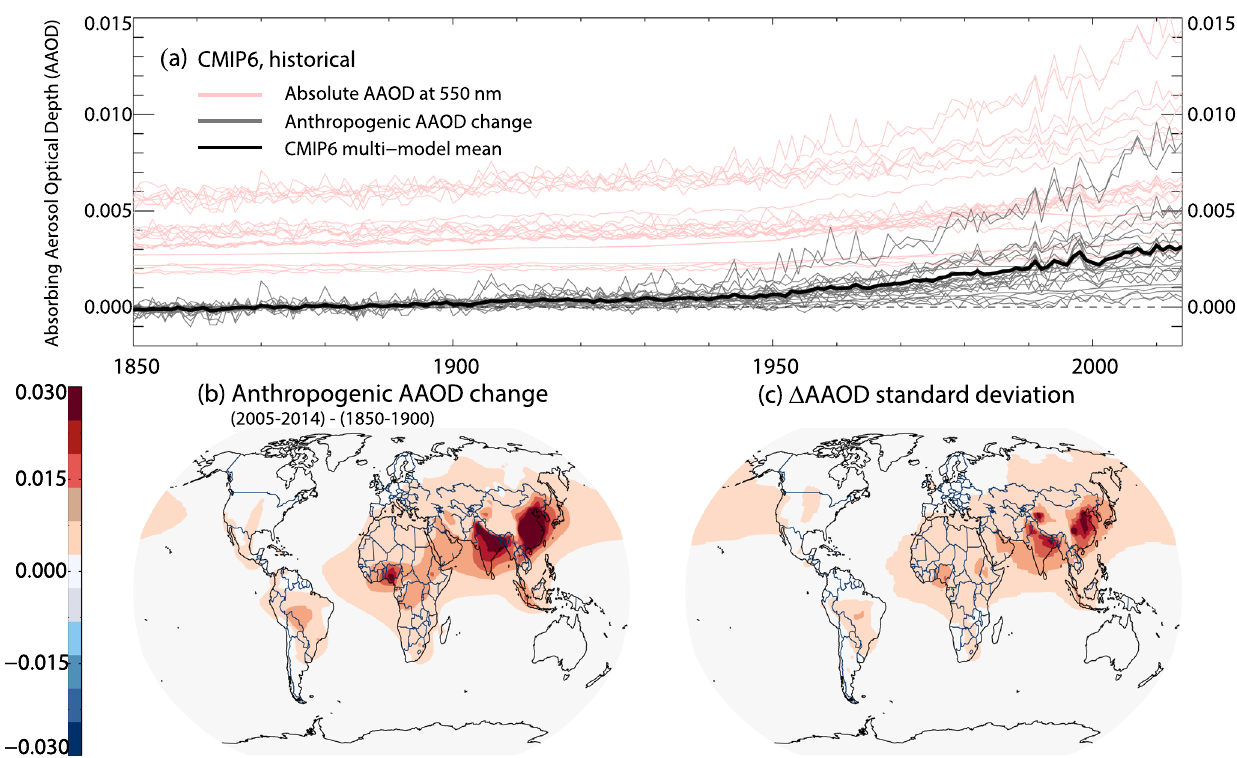
Fig. 1 CMIP6 model spread in simulated absorbing aerosol optical depth (AAOD). a Absolute (red) and anthropogenic (black) AAOD over the historical era. b Geographical pattern of the multi-model annual mean AAOD change. c Inter-model standard deviation of AAOD change over the historical